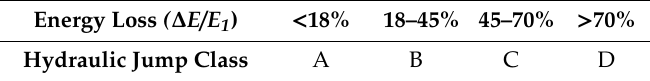
Table 2. Classification of the hydraulic jump based on energy